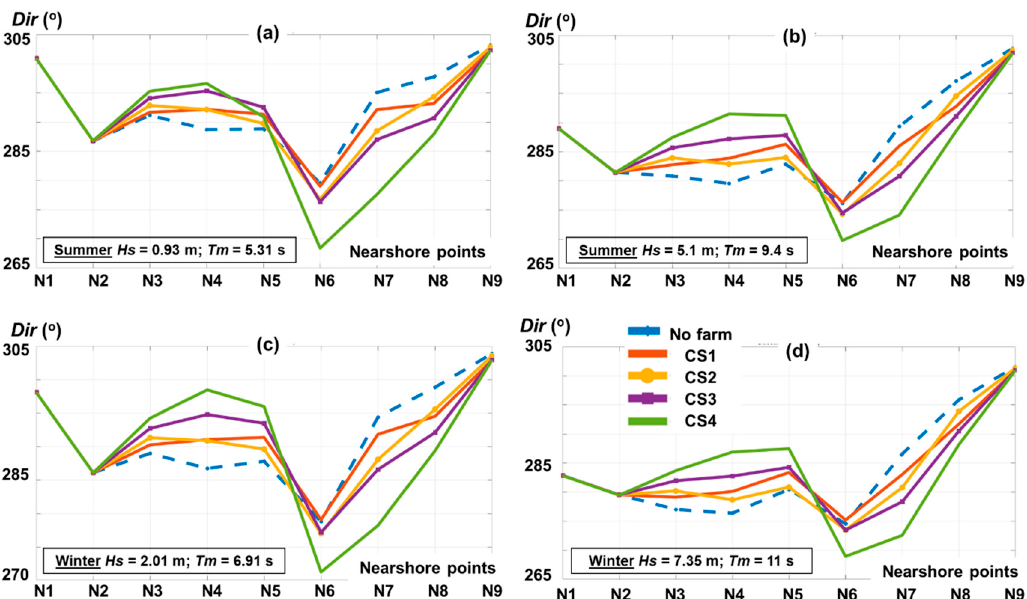
Figure 10. Wave directions (°) corresponding to the N-points for the four different scenarios